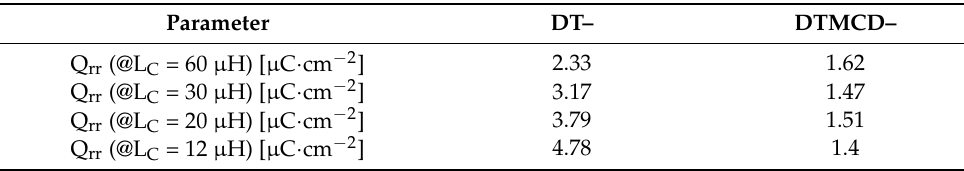
Table 2. Reverse recovery charge according to L C value.